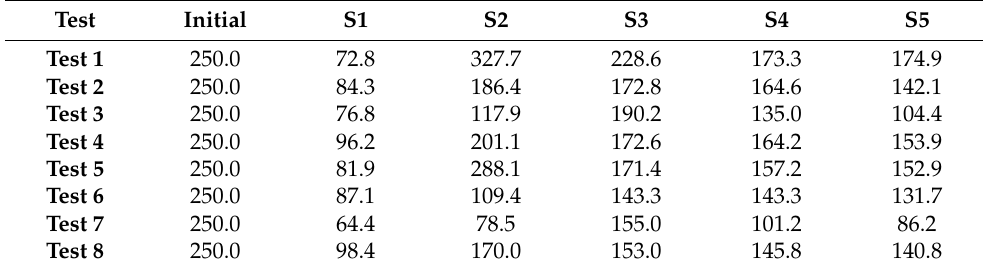
Table 4. Results of fractionation change of Cu after EK